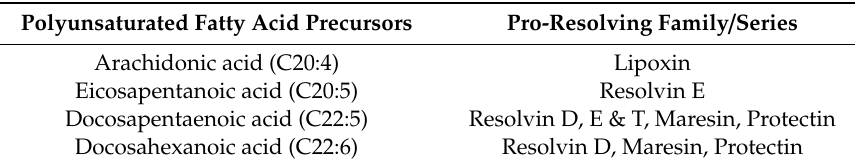
Table 1. Pro-resolving mediators and their